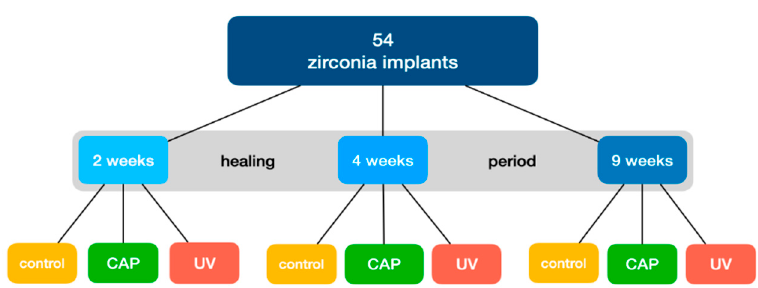
Figure 2. Study Figure 2. Study flowchart. Figure 2. Study flowchart.